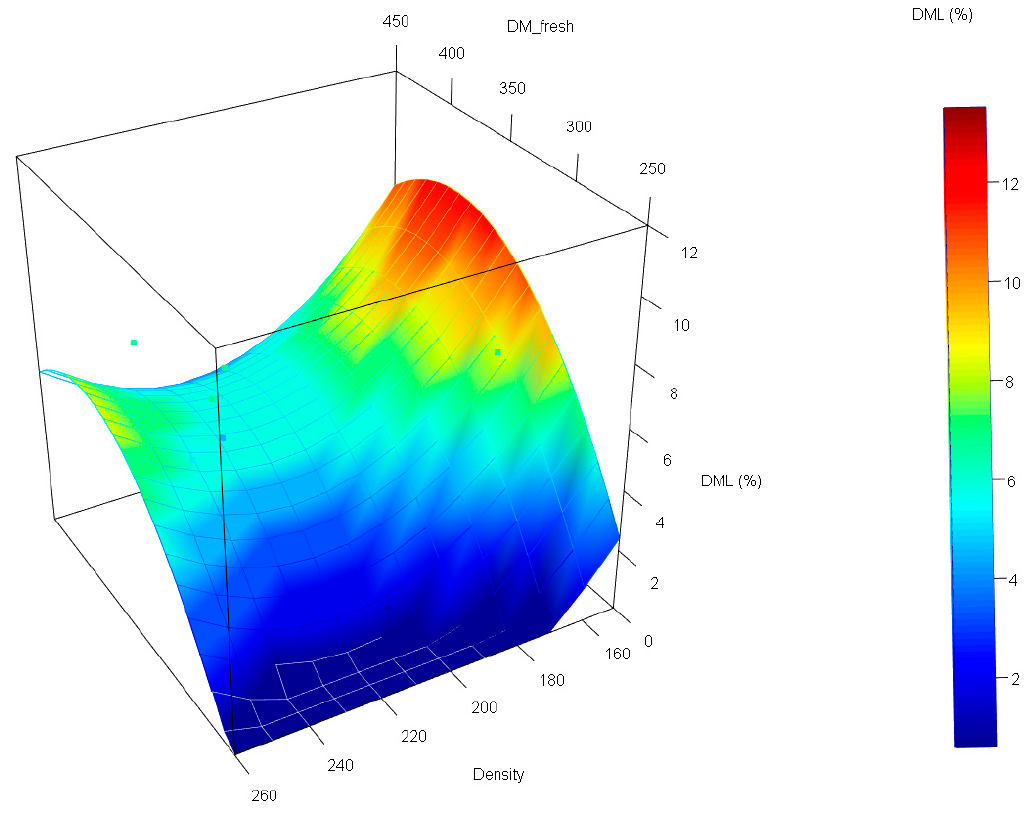
Figure 2. Dry matter losses (DML) of whole-plant maize (WPM) silage (%) according to the fresh forage DM (DM_fresh) content (g kg − 1 ) and the DM density (kg DM m − 3 ).